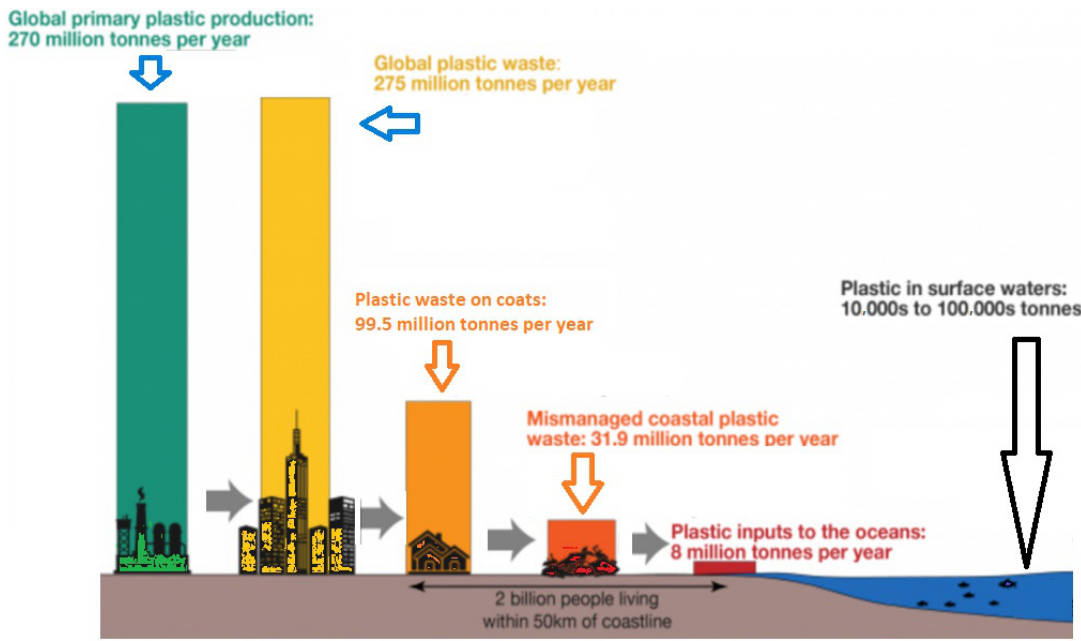
Figure 4. The pathway by which plastic enters the world’s oceans: estimates of global plastics entering the oceans from land-based sources in 2010 (based on data from Jambeck et al. [30]).